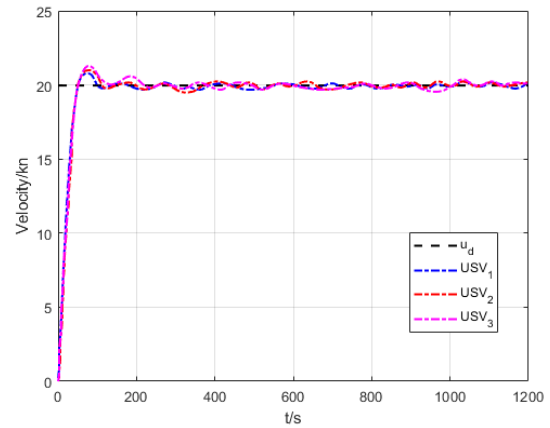
Figure 37. Variation of velocity.